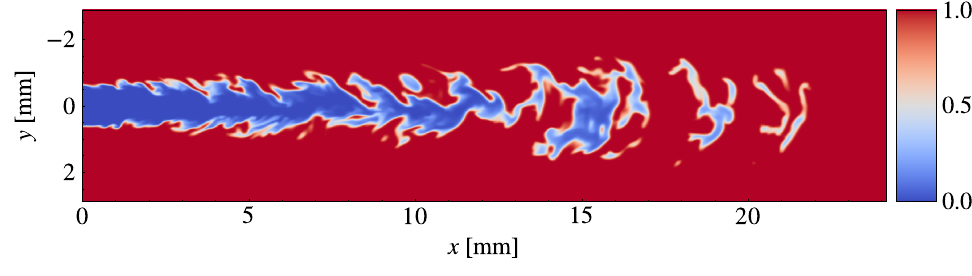
Figure 2. Slice of progress-variable field in R2